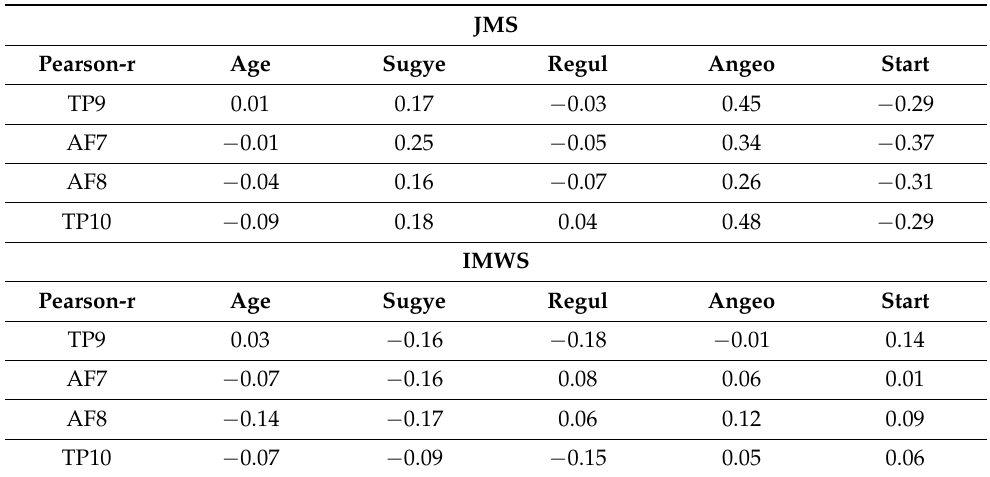
Table 2. Pearson-r values between EEG channels and questionnaire items.